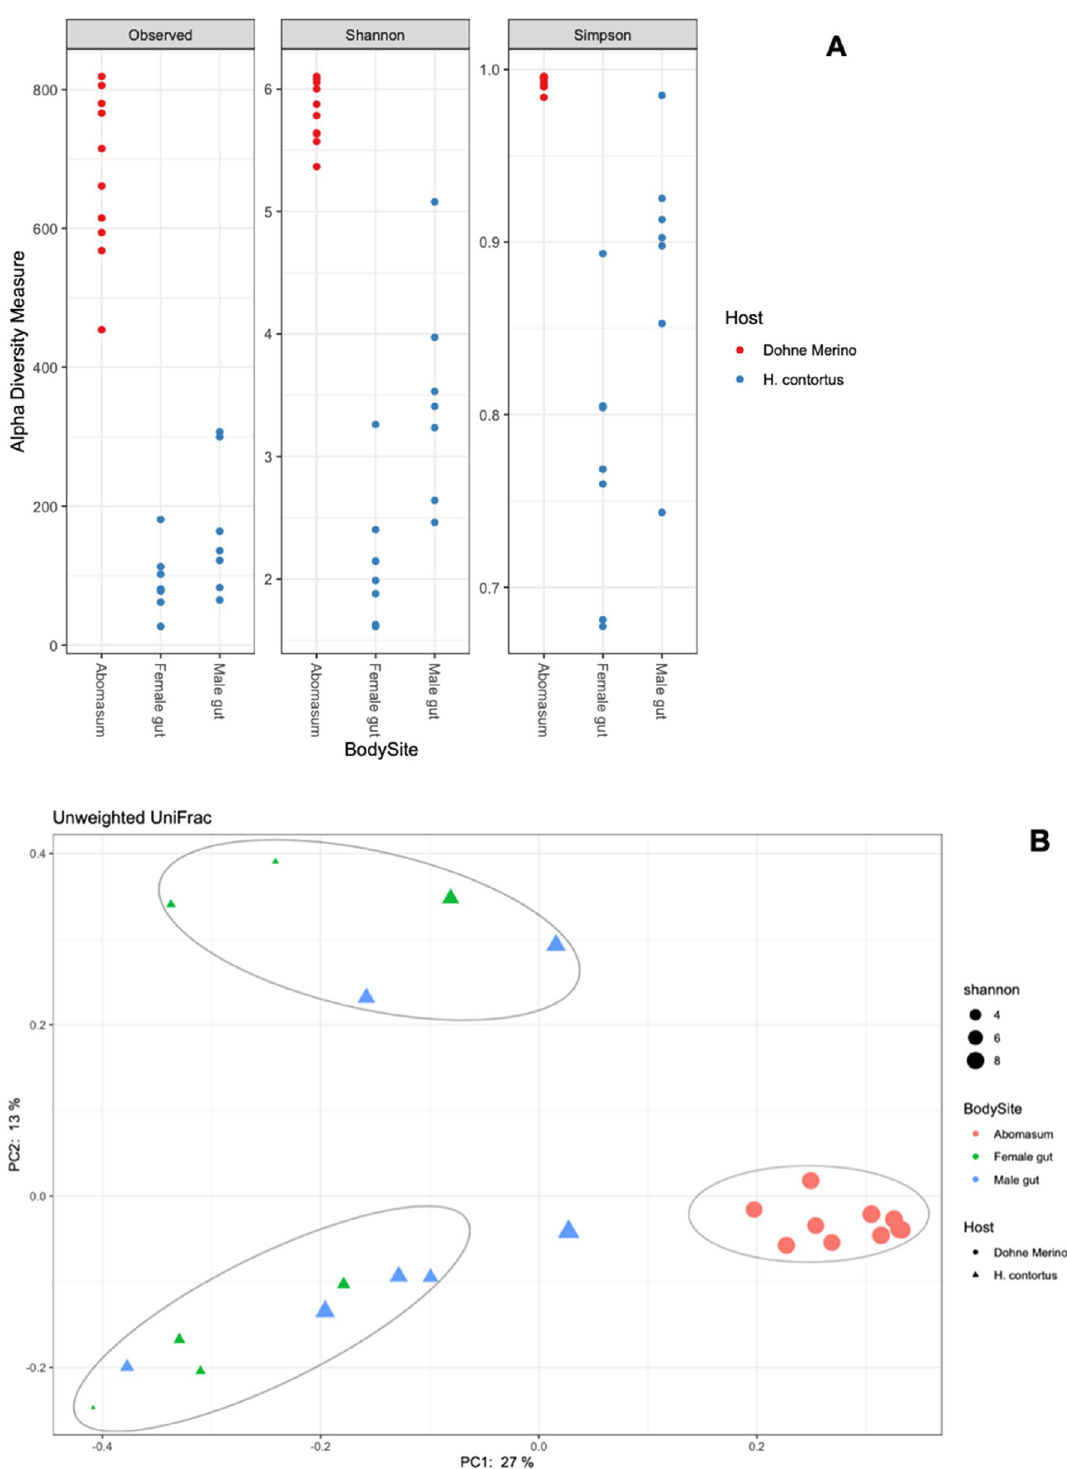
Figure 1. Principal coordinate analysis (PCoA) based on unweighted UniFrac distances ( B ). Alpha diversity ( A ) matrices, observed OTUs, Shannon, Simpson of the abomasum content, adult male and female H. contortus microbiome at 97% identity. Data represent average values from pooled